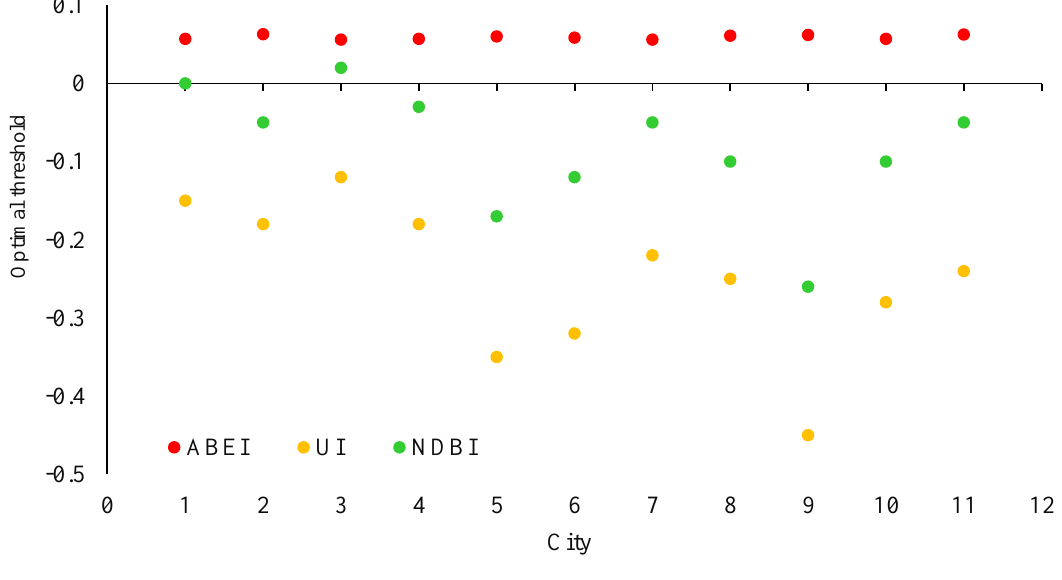
Figure 8. Optimal thresholds of the three indices by city.